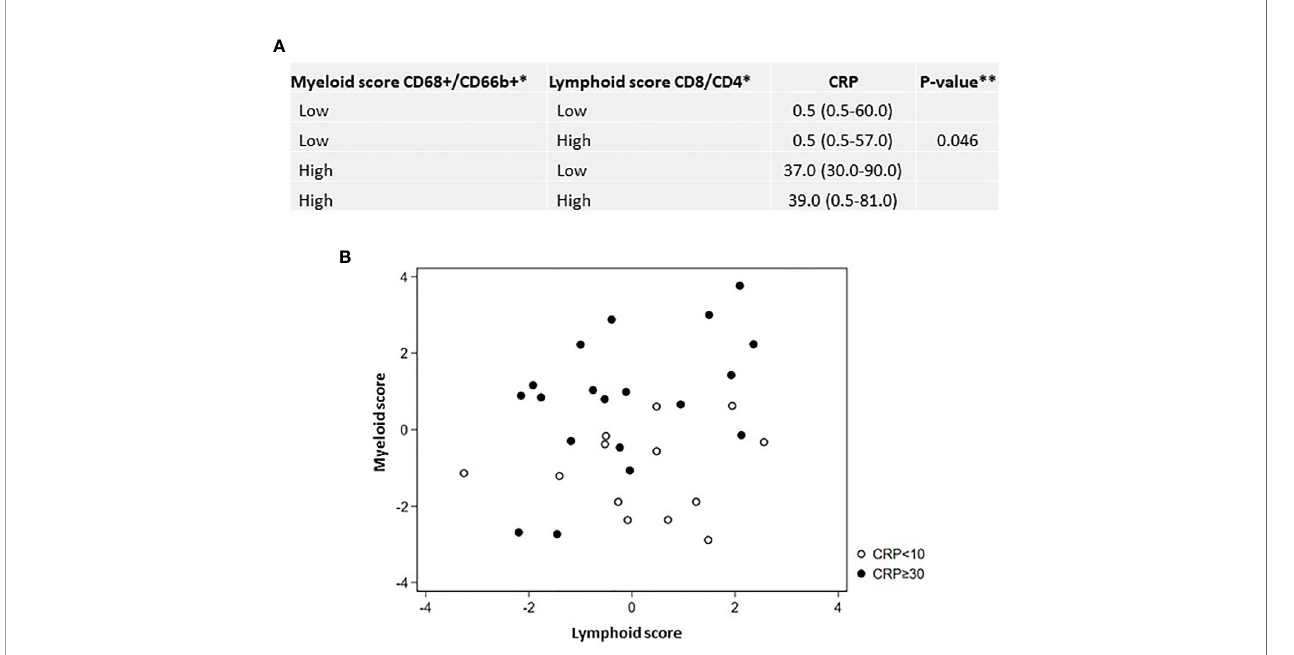
FIGURE 5 | Composite lymphoid and myeloid immune scores correlate differentially with systemic in fl ammation. (A) Median (range) CRP by myeloid vs. lymphoid composite immune scores. (B) Lymphoid and myeloid composite scores in CRP-high and -low patients. *Immune scores based upon directly tumor-in fi ltrating immune cell densities at the tumor center. Lymphoid composite score: compounded densities of CD8+T lymphocytes and CD4+T lymphocytes. Myeloid composite score: compounded densities of CD68+ macrophages (inclusive CD68PDL1+) and CD66b+ neutrophiles. **p-value obtained using the Kruskal – Wallis test comparing all four